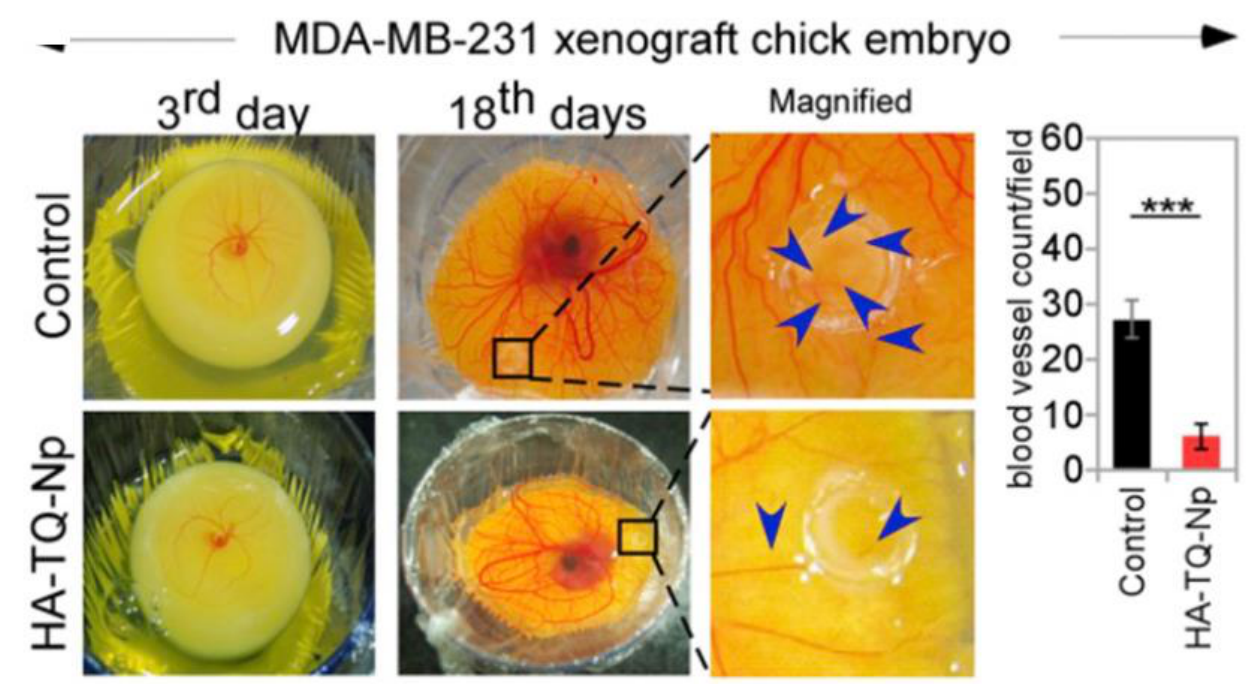
Figure 6. Digital images of TQN-P-HA NP-untreated (control) and -treated MDA-MB-231 chick embryo xenograft models showing the angiogenic activity in both the groups. Reproduced with permission from reference [175]. *** p < 0.001.